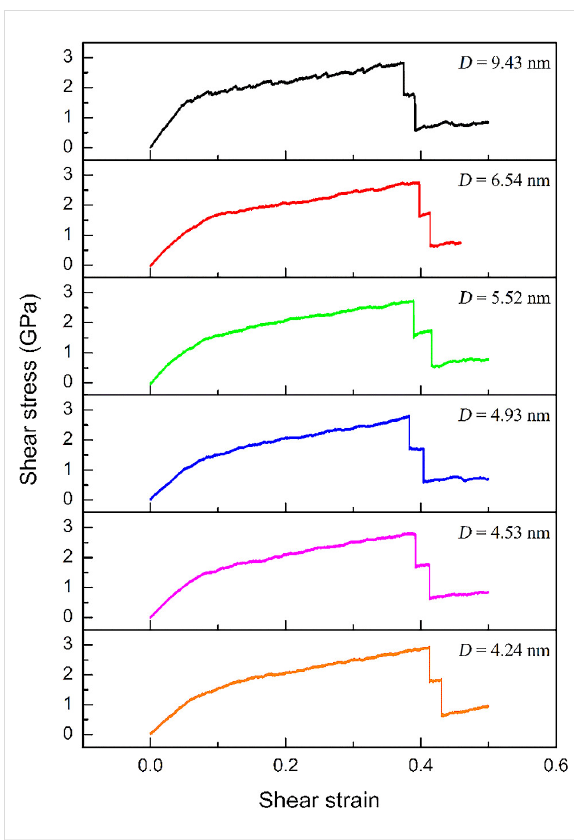
Figure 14: Stress–strain curves of zigzag GPCuNL composites with different grain sizes.